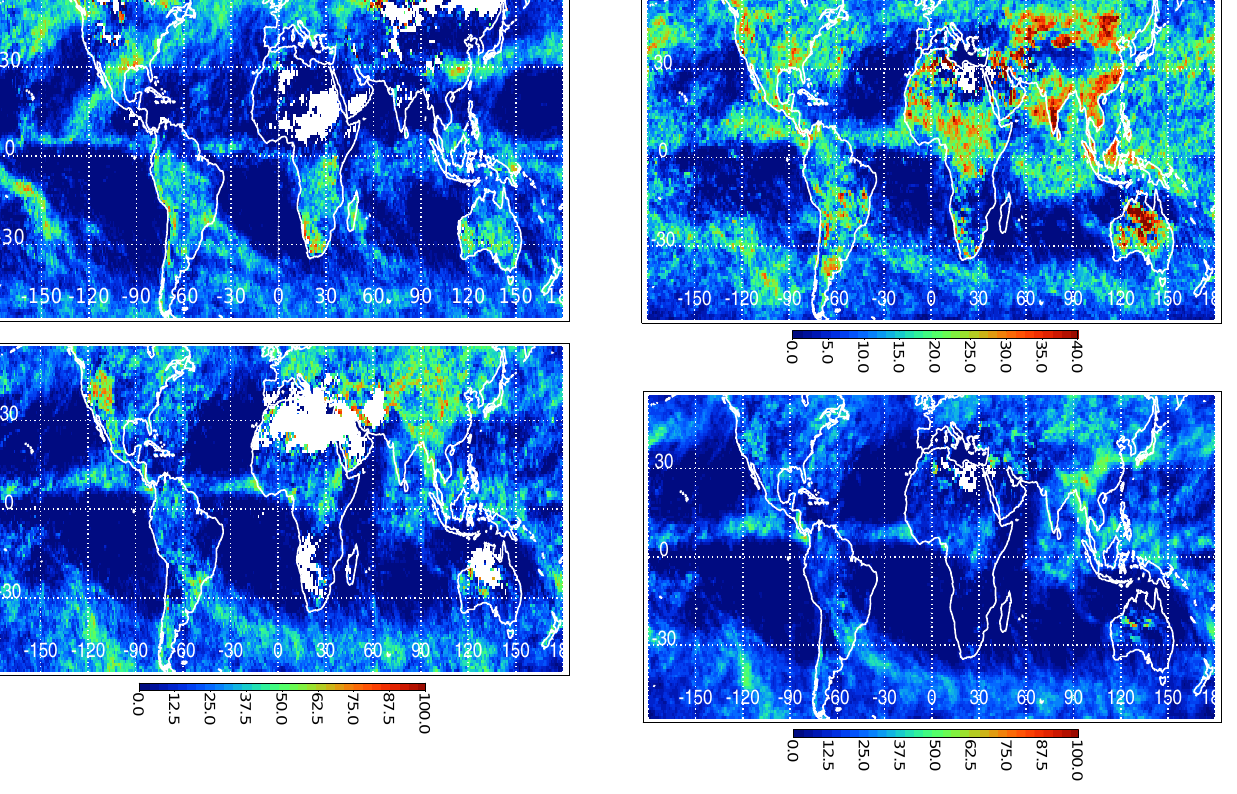
Fig. 13. Fraction of cloudy pixels designated as vertically-extended by the OMI/MODIS algorithm for January (top) and July (bottom) 2007. Fig. 14. Results for MODIS-only, July 2007 derived from the (5km) 2 data: Fraction of cloudy pixels designated as multi-layer (upper, note that the scale is different from all similar panels) and vertically-extended